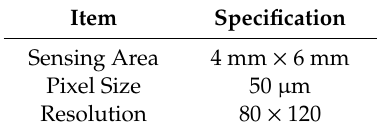
Table 1. Specifications of Complementary Metal Oxide Semiconductor ( CMOS ) .